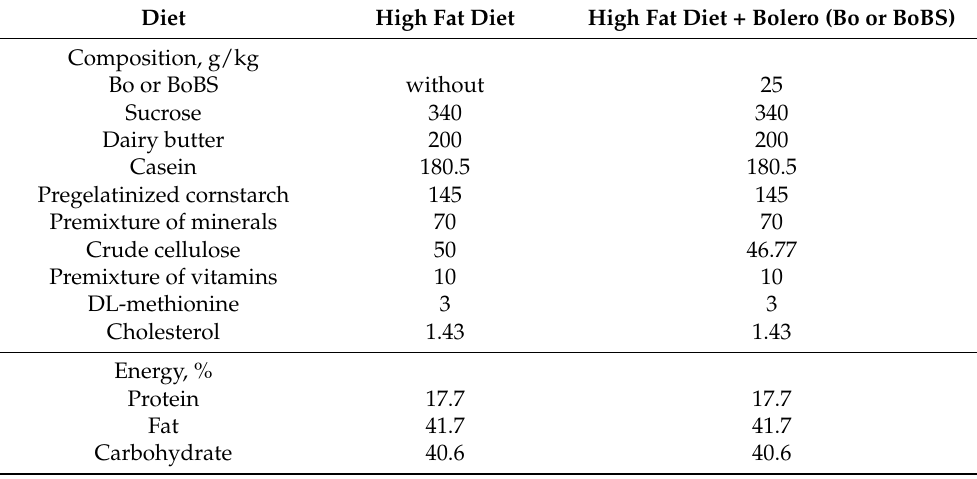
Table 1. Nutritional composition and energy content of